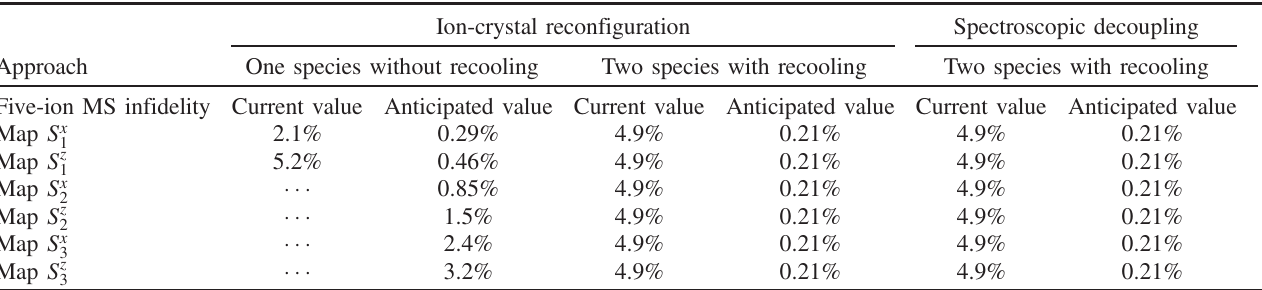
TABLE V. MS -gate infidelities in different QEC cycle scenarios: We use our model of the MS gate ε ¼ ε and (20) to reproduce the current performance of five-ion MS gates in Table II. Then, we use the model to predict the infidelities for the stabilizer mappings for the scenarios of QEC with a warmer ion background and those with the expected improved conditions.